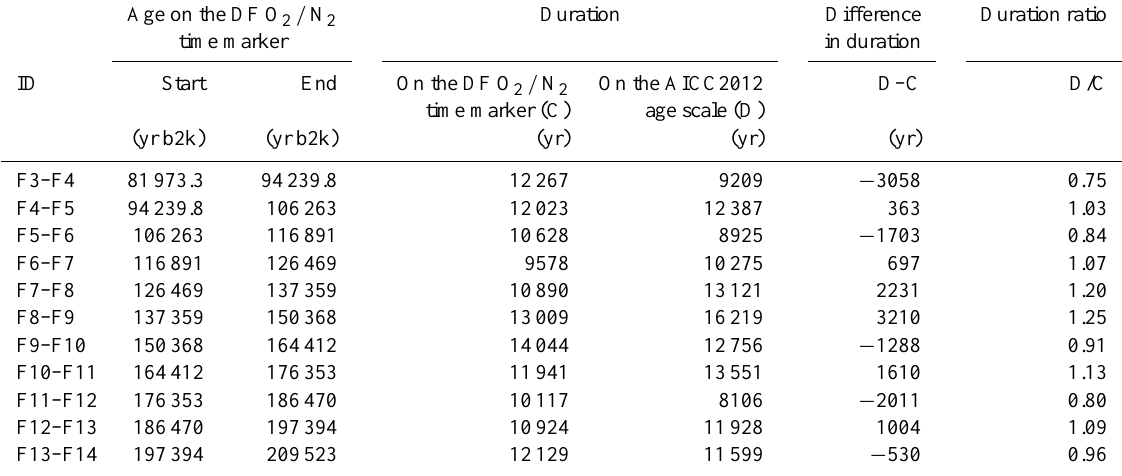
Table 3. Duration between O 2 / N 2 time markers on two different timescales and their differences and ratio. Age on the DF O 2 / N